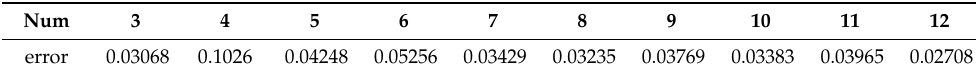
Table 6. Results of experiments to determine the number of